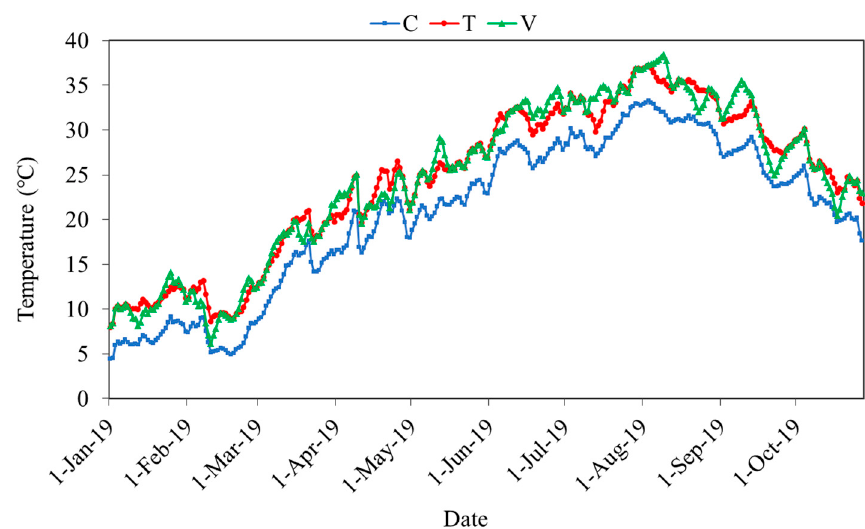
Figure 1. Water temperature for all treatments during the experiment. C, ambient temperature; T, constant warming; V, variable warming. Table 1. Mean water quality for all treatments during the experiment. Values are mean ± SE. C, ambient temperature; T, +4 ℃ constant warming; V, variable warming. The letters above the data represent significant differences between treatments ( p < 0.05, Tukey’s test).